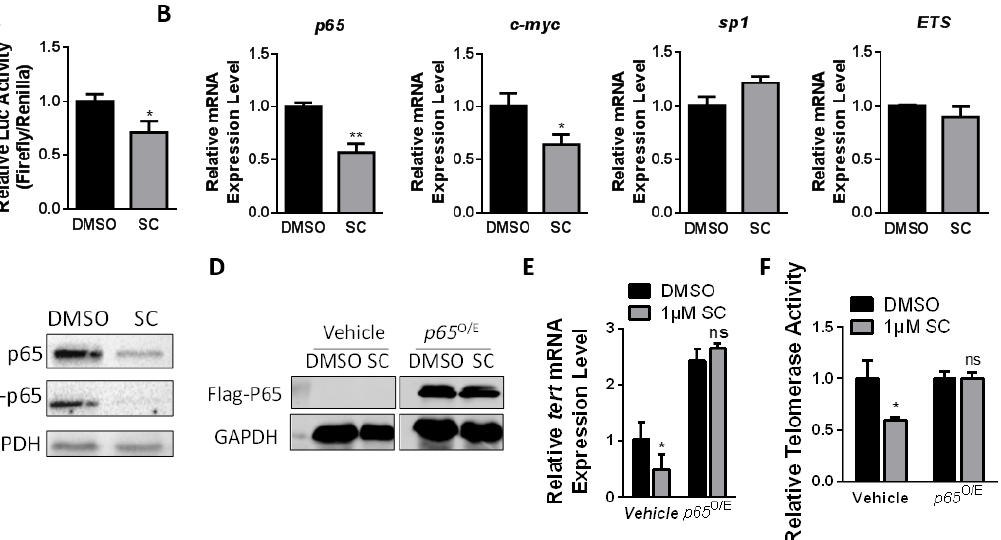
Figure 4. SC inhibited telomerase activity depending on p65 expression in cancer cells. ( A ) The dual luciferase reporter assay suggested the compound has suppressive effects on hTERT transcriptional activities. ( B ) The relative mRNA levels of partial common transcription factors, which have been reported to regulate hTERT transcription. ( C ) The protein levels of pan-p65 and pi-p65 in cancer cells after 1 µ M SC treatment for 48 h. DMSO served as a control. ( D ) Western blot was carried out to detect the protein level of overexpressed p65 in sanguinarine chloride-treated cells. ( E ) The mRNA level of hTERT was rescued in the SC-treated group by overexpressing p65. ( F ) Telomerase activity assay in p65 re-introduced HTC75 cells with SC treatment for 48 h. All the analyses were from triplicate samples (* p < 0.05, ** p < 0.01, ns means no significance).